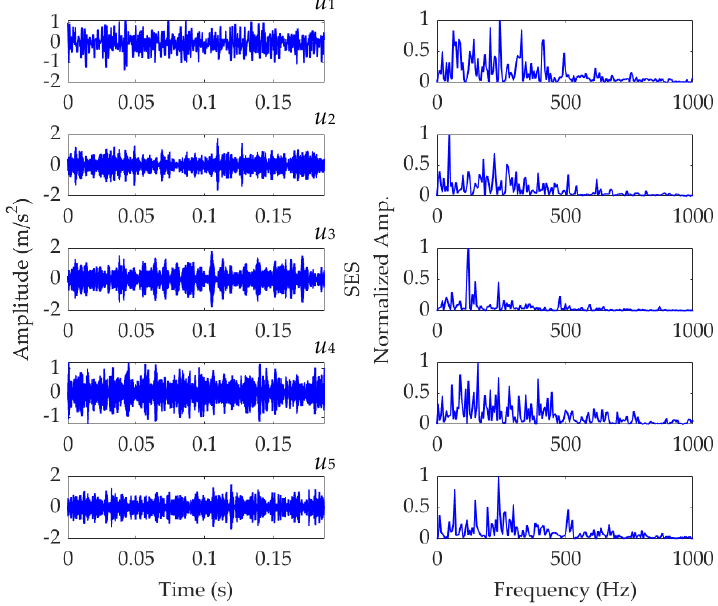
Figure 8. Results of the simulated vibration signal x ( t ) obtained by VMD.